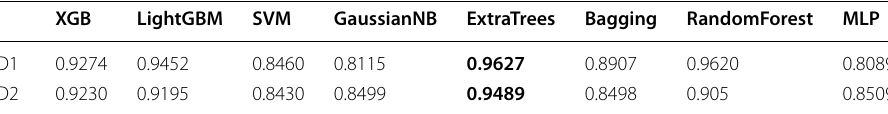
Table 5 Performance of ML models (AUC ROC) classifying students into Good, AtRisk, and Failed